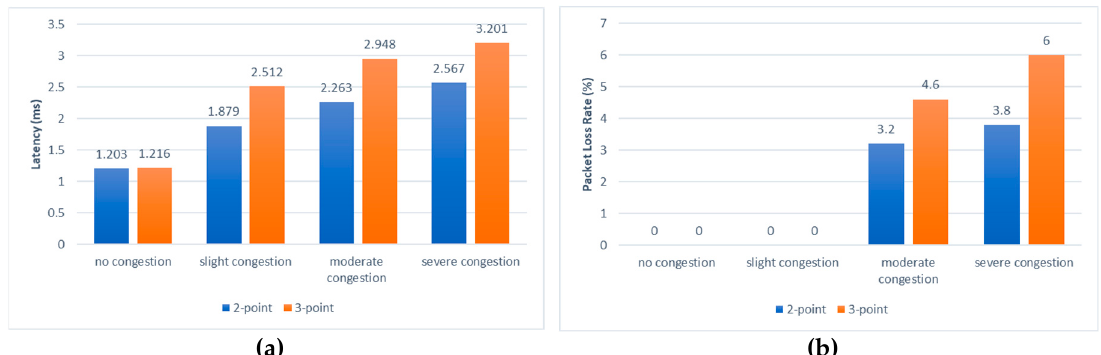
Figure 16. ( a ) Latency comparison of 2-point and 3-point; ( b ) Packet loss comparison of 2-point and 3-point.